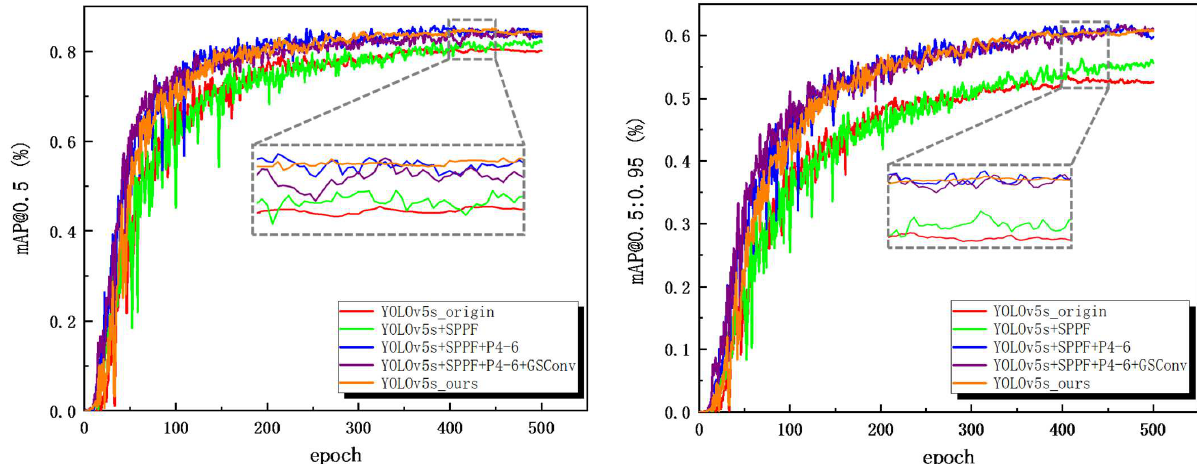
Figure 10. The ablation experimental results of the improved methods.